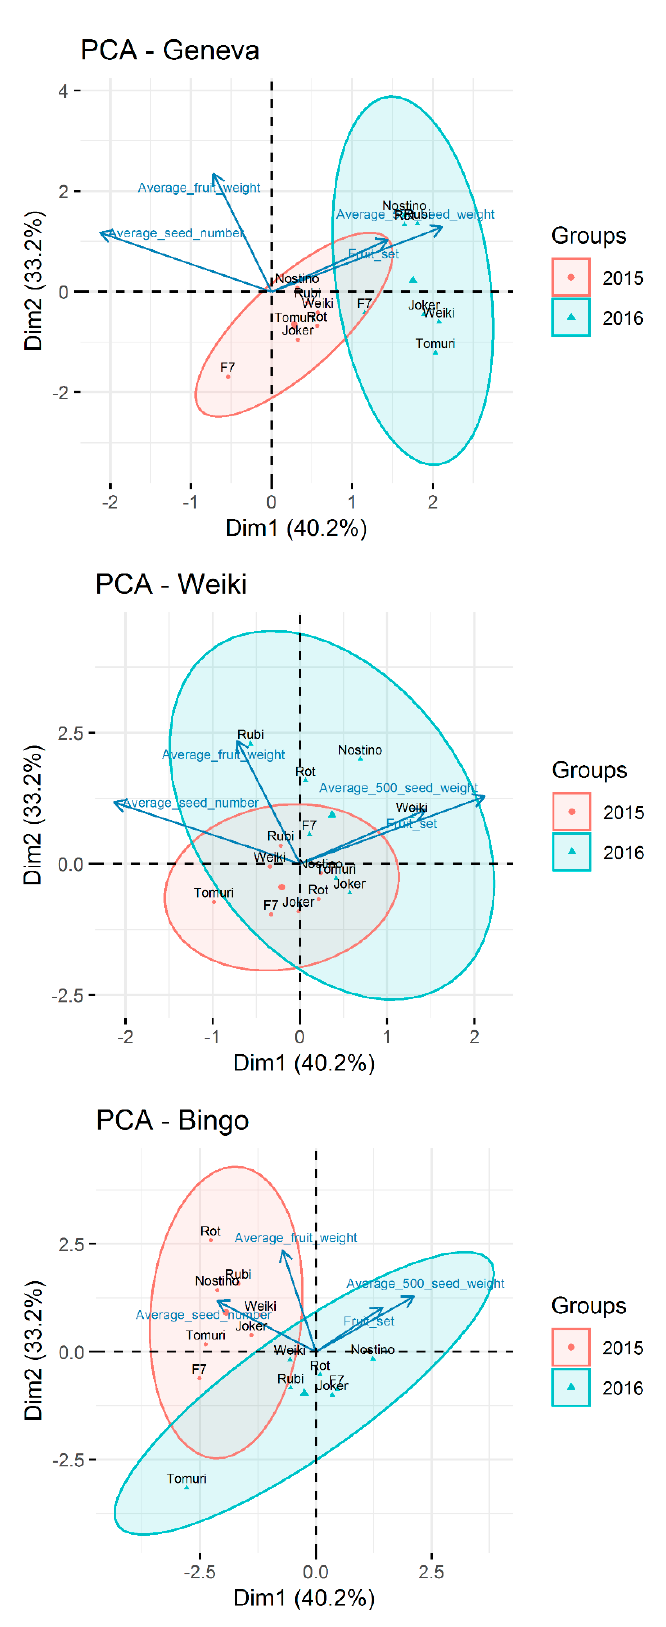
Figure 4. Principal component analysis (PCA) biplot for all model components based on first and second principal components. Plots obtained for the combined data from years 2015 and 2016 and presented for each female cultivar separately.